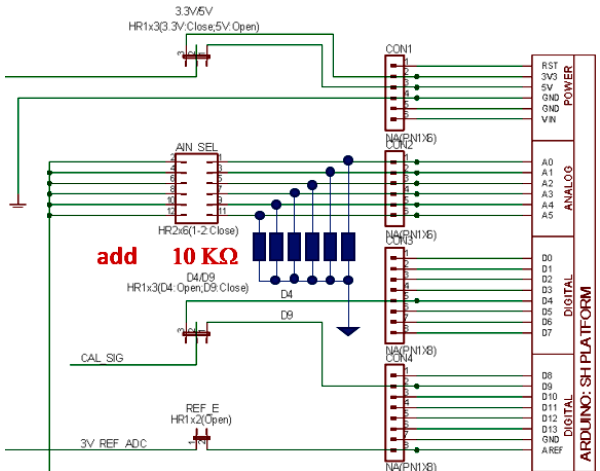
Figure 6. Application of pull-down resistors on the analog pins of the ECG/EMG shield.